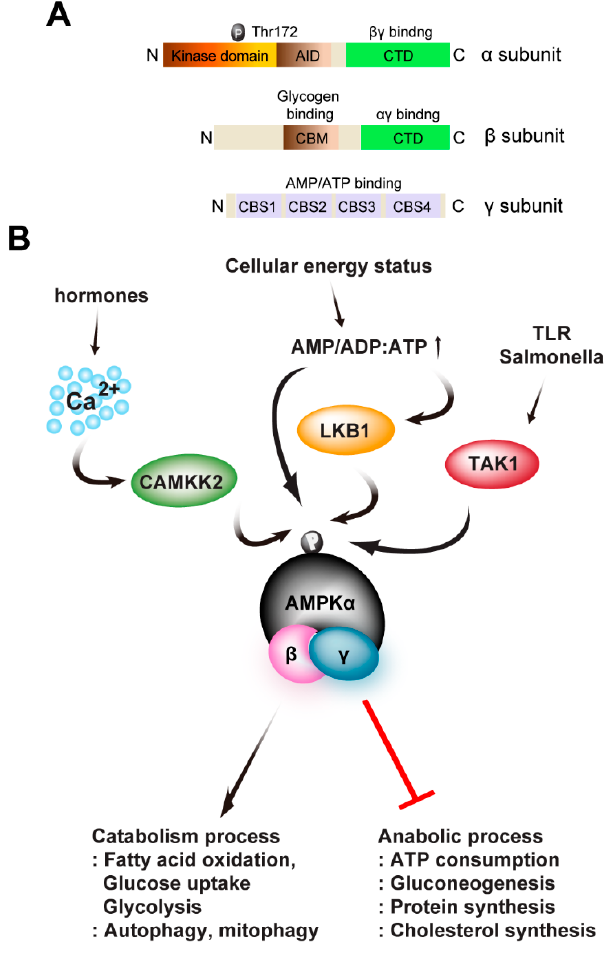
Figure 1. Domain structures of the 5 ′ AMP-activated protein kinase (AMPK) subunits and the mechanisms that regulate activation of AMPK signaling pathways. ( A ) Conserved domain structure of AMPK subunits consisting of a catalytic α subunit, scaffolding β subunit, and regulatory γ subunit. AID, autoinhibitory domain; CBM, carbohydrate-binding module; CBS, cystathionine-beta-synthase; CTD, C-terminal domain. ( B ) AMPK is activated by the upstream kinases LKB1, CAMKK2 and TAK1 associated with the canonical pathway (triggered by an increased cellular AMP/ATP ratio) or the non- canonical pathway (triggered by an increased intracellular Ca 2+ concentration or infection/TLR activation). Activated AMPK modulates cellular homeostasis, such as energy metabolism and autophagy, and mitochondrial homeostasis. (black arrow indicate activation/increase; bar-headed red arrow indicates inhibition/decrease). CAMKK2, calcium/calmodulin-dependent kinase kinase 2; LKB1, liver kinase B1; TAK1, Transforming growth factor- β -activated kinase 1; TLR, Toll-like receptor.